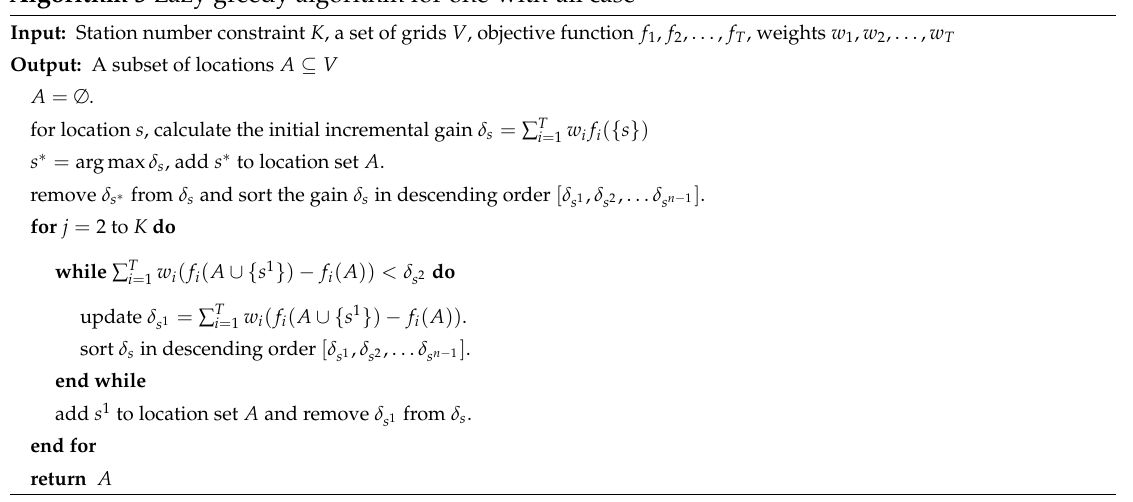
Algorithm 3 Lazy greedy algorithm for one-with-all